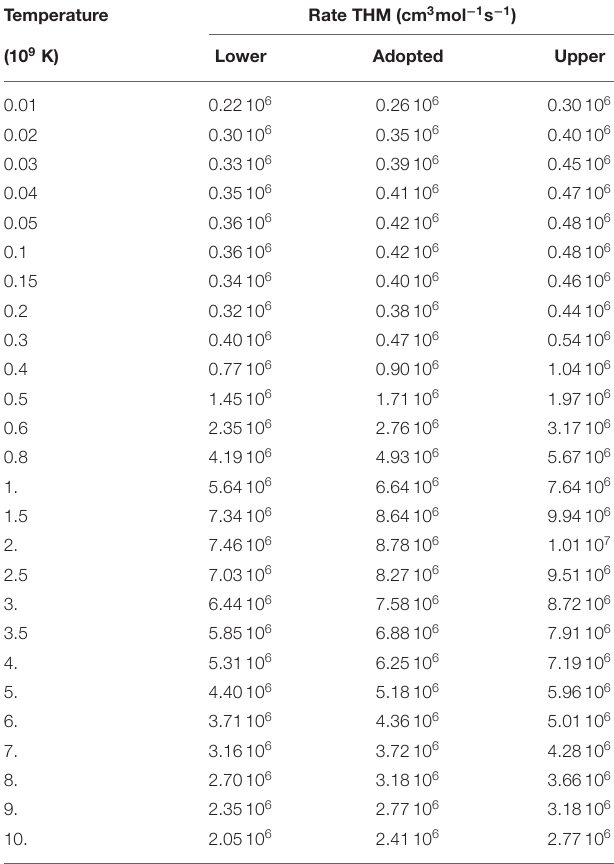
TABLE 7 | Rate of the 17 O( n , α ) 14 C